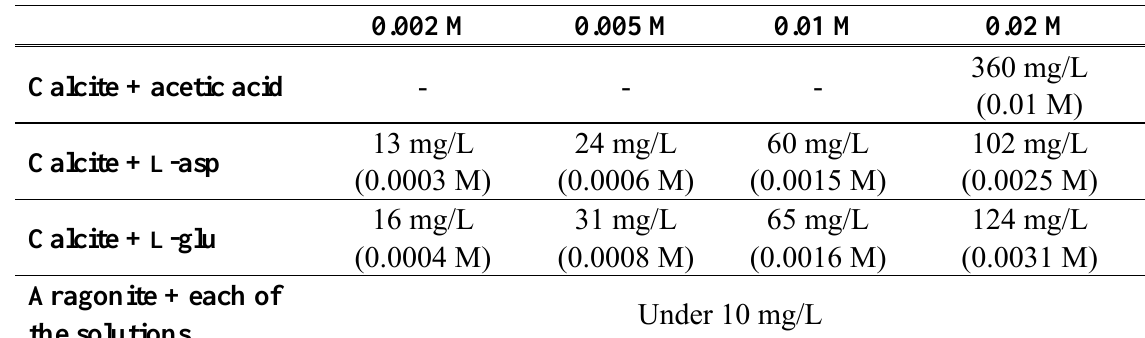
Table 1. Ca concentration at the dissolution for four hours. Ca concentrations by the calcite dissolution depended on the initial concentration and acidic solutions. Ca molarity (M) of in each filtrate was described in parenthesis. Ca concentrations in dissolution filtrates of aragonite could be detected by AAS